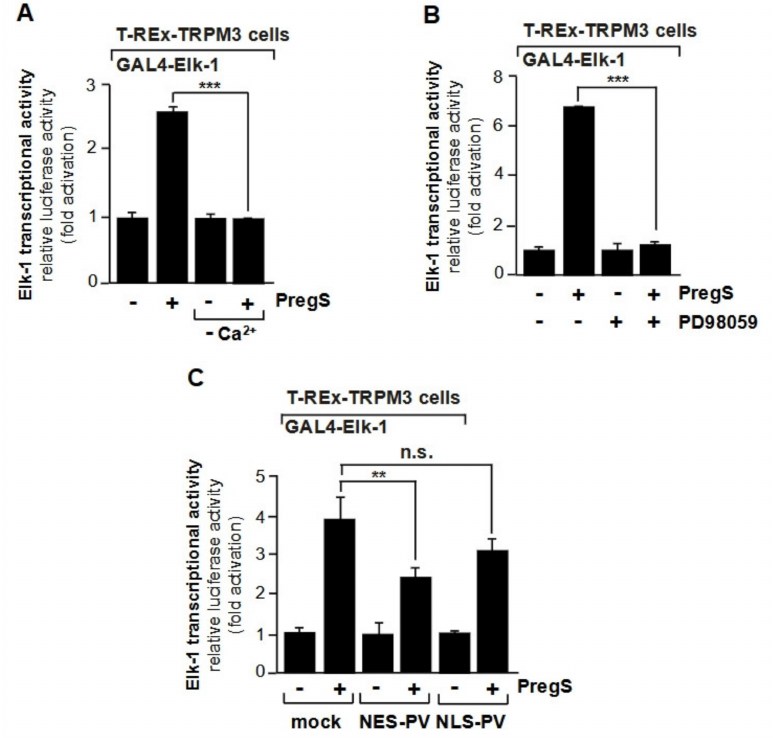
Figure 4. Stimulation of the TRPM3 Ca 2+ channel increases the transcriptional activation potential of Elk-1, involving a rise of cytosolic Ca 2+ . ( A ) An influx of Ca 2+ ions into the cells is essential for the activation of Elk-1 following stimulation of TRPM3 Ca 2+ channels. HEK293 expressing TRPM3 Ca 2+ channels were infected with a lentivirus containing a GAL4-responsive luciferase reporter gene ( UAS5Sp12.luc ). In addition, cells were infected with a lentivirus encoding GAL4-Elk-1 fusion protein, used to monitor the transcriptional activation potential of Elk-1. The cells were serum-starved for 24 h in either DMEM or Ca 2+ -free medium. Cells were stimulated with the TRPM3 ligand pregnenolone sulfate (PregS, 20 µ M) for 24 h. Cell extracts were prepared and analyzed for luciferase activities. Luciferase activity was normalized to the protein concentration. ( B ) Extracellular